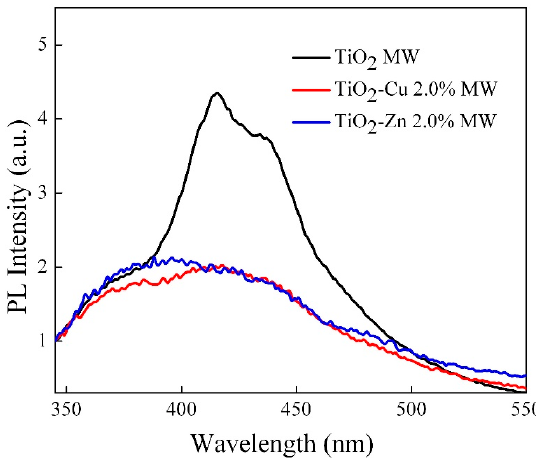
Figure 15. UV − Vis absorption spectra of ( a ) Cu/Zn-doped TiO 2 MW samples and ( b ) graphic repre- sentation of the Kubelka–Munk function for indirect transitions.